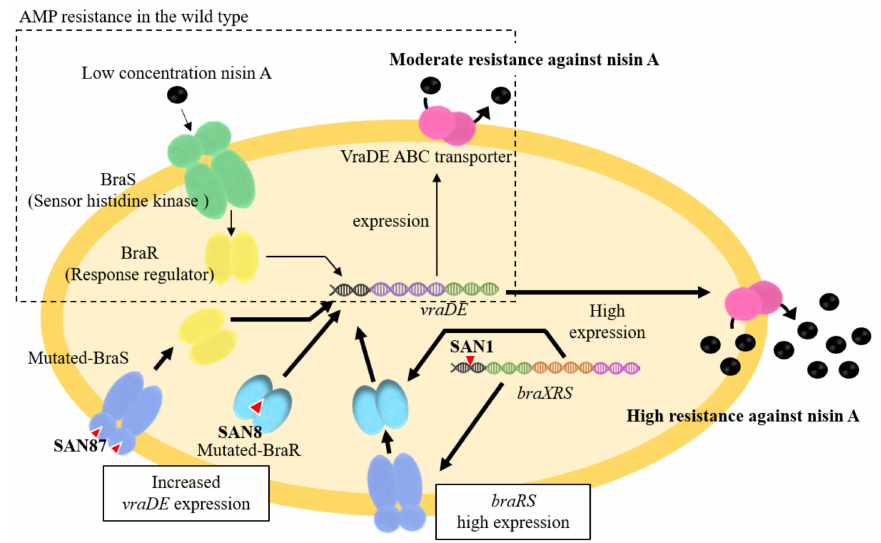
Figure 4. Mechanism underlying the high nisin A resistance of the BraRS mutant. In the MW2 strain, the BraRS-VraDE system responds to low concentrations of nisin A (upper side). In highly nisin A-resistant strains, mutation (red triangle) occurs in the braXRS region, resulting in high expression of vraDE and resistance to nisin A (lower